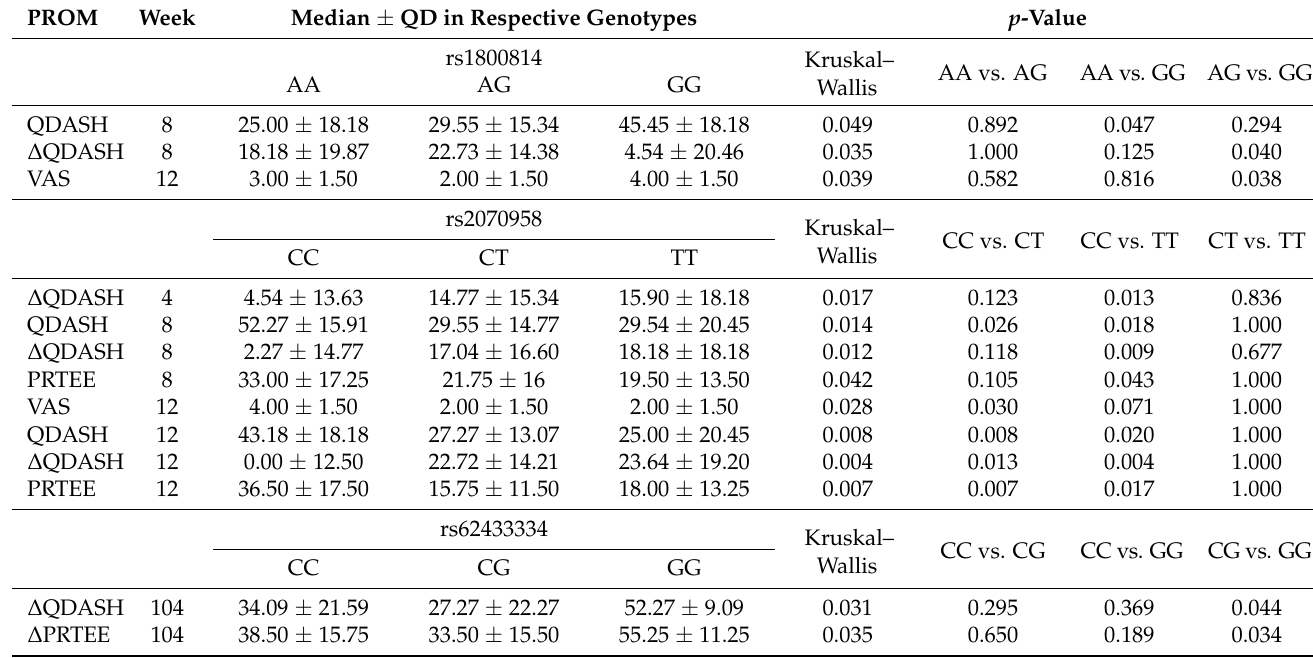
Table 4. Median ( ± QD) values of PROMs for genotypes of the PDGFA gene polymorphisms (addi- tive